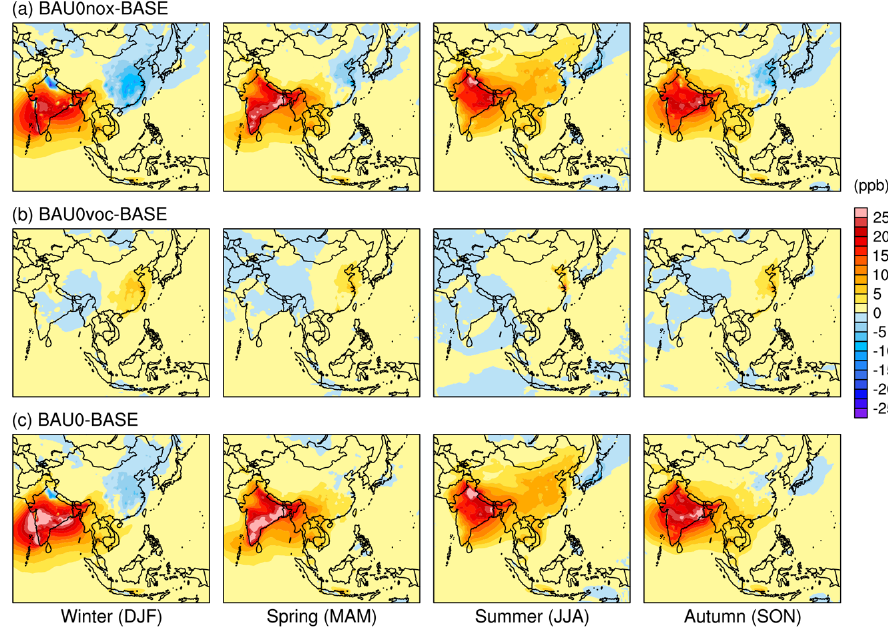
Figure 9. Horizontal distributions of differences in simulated seasonal mean surface ozone concentrations between (a) BAU0nox and BASE, (b) BAU0voc and BASE, and (c) BAU0 and